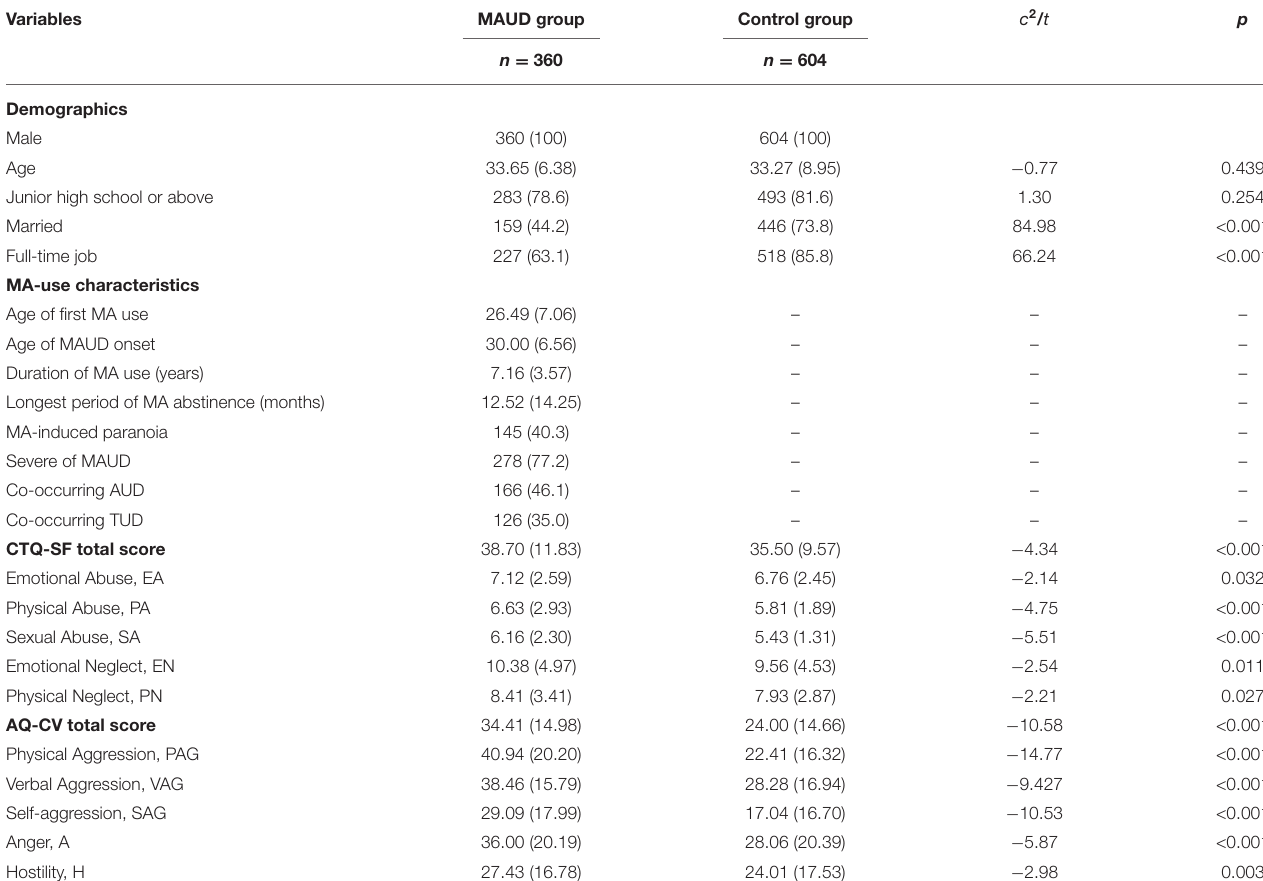
TABLE 1 | Sample characteristics and group